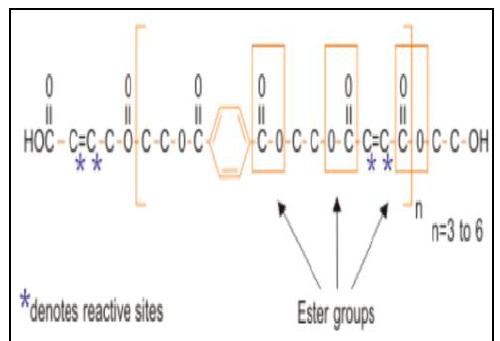
Fig.1: Unsaturated polyester [9].